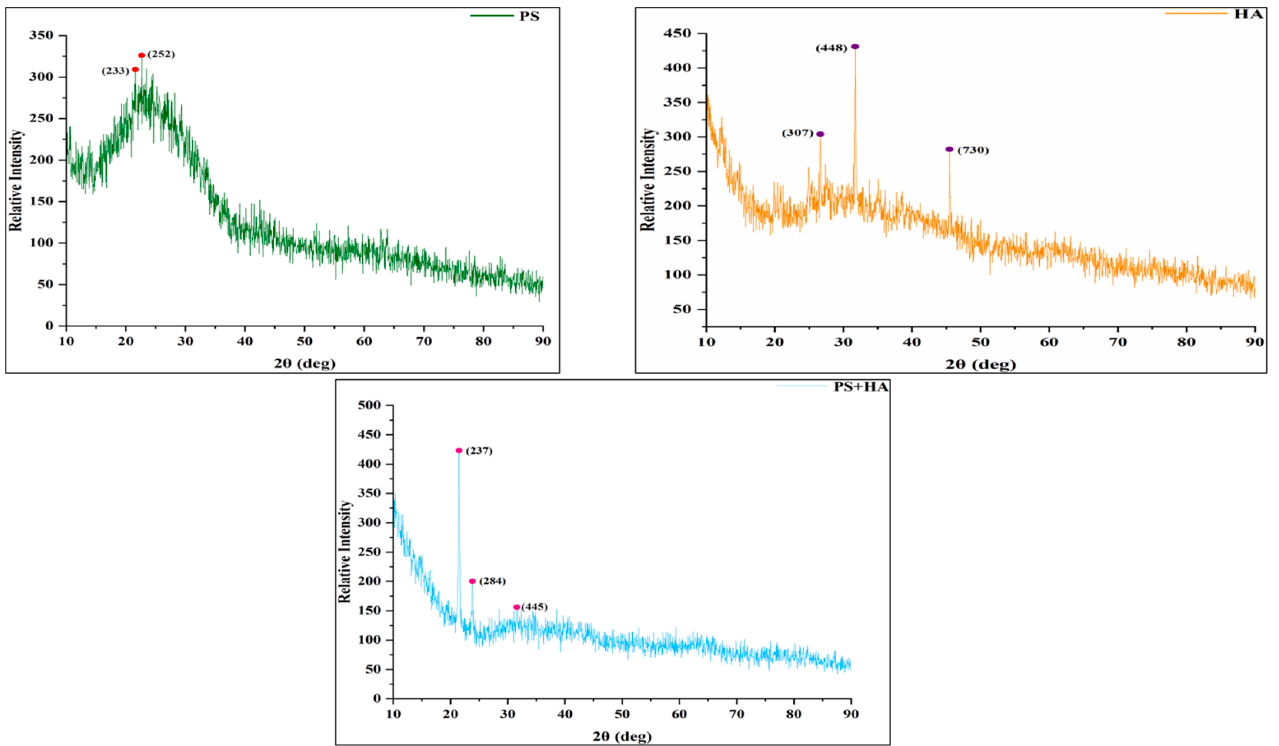
Figure 3. XRD observation patterns: PS, HA, and PS + HA.